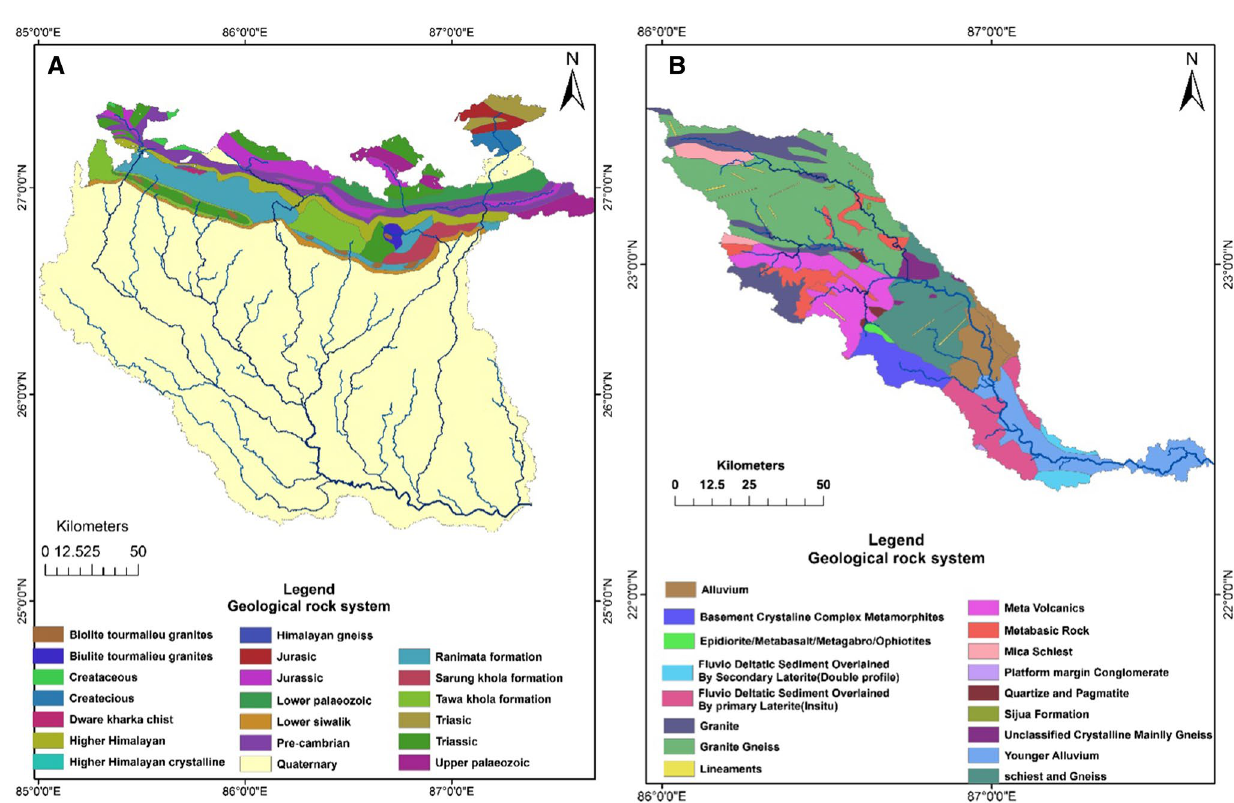
Fig. 2 Geological map of River basin a Kosi and b